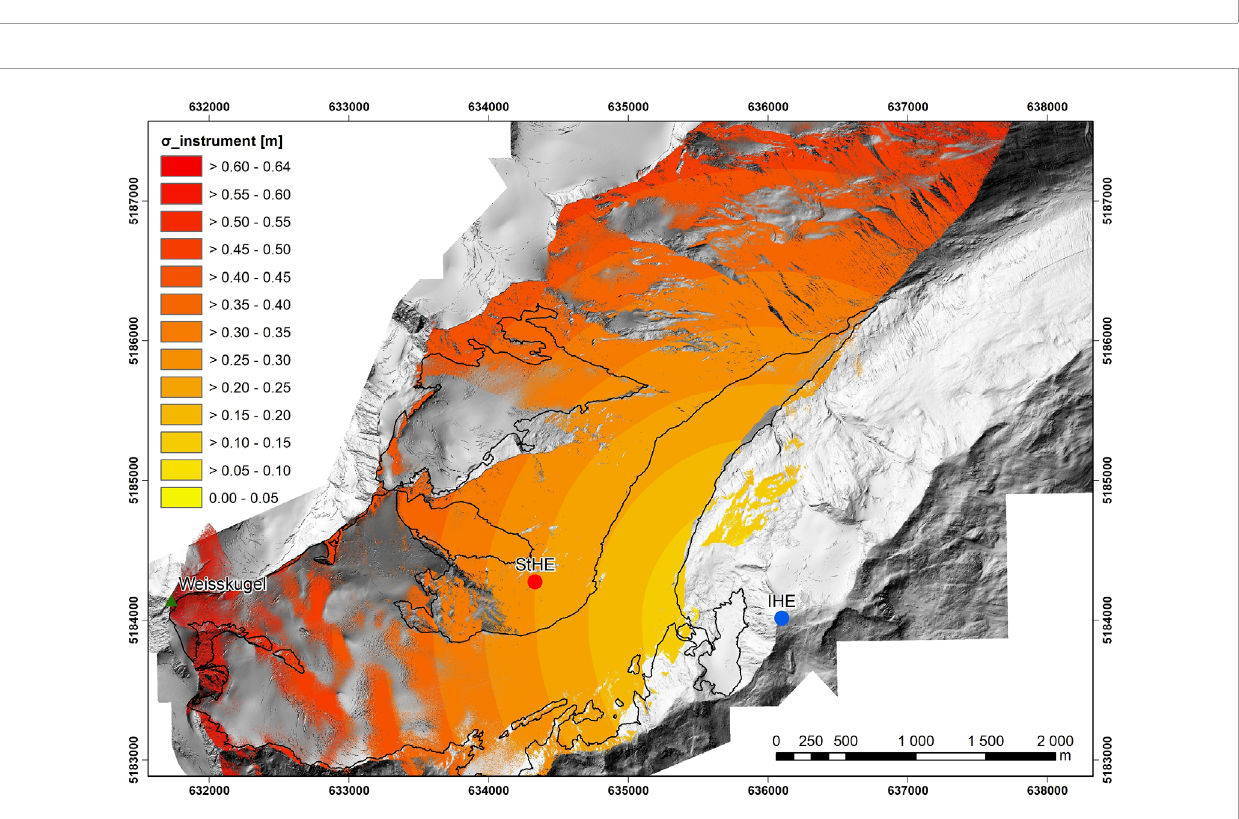
FIGURE 4 Distributed TLS uncertainty related to instrument and hardware limitations ( σ instrument